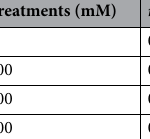
Treatments (mM) ri